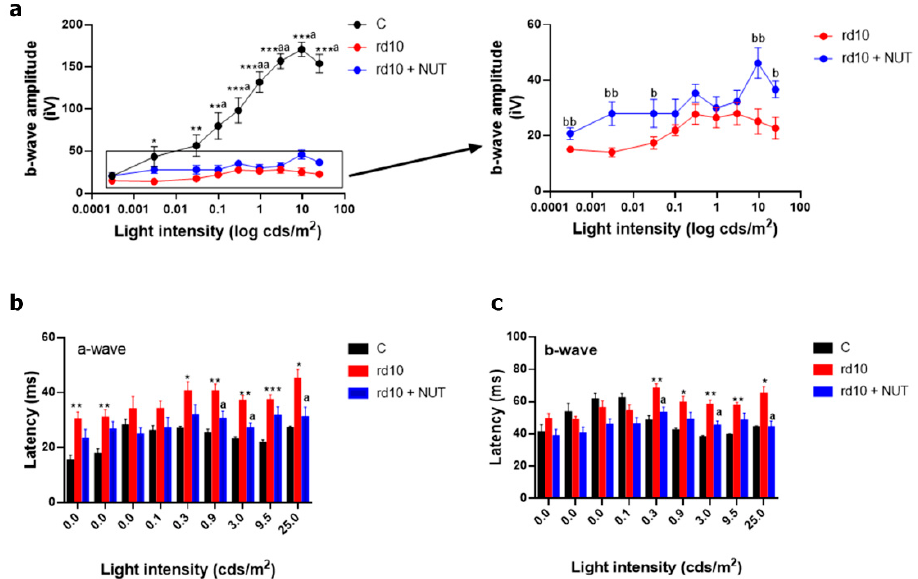
Figure 1. Effect of oral administration of nutraceuticals on retinal degeneration in rd10 retinas at